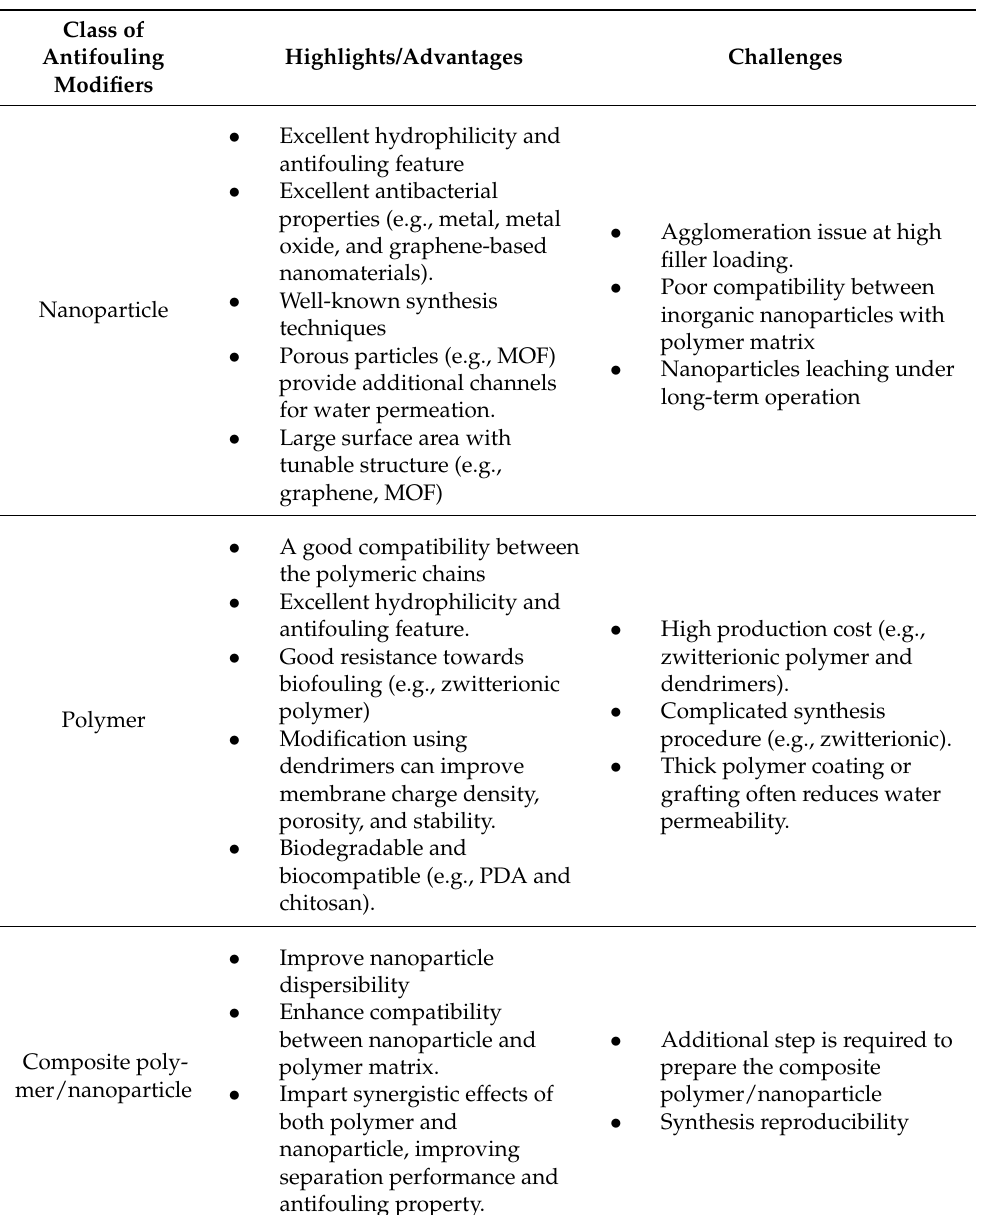
Table 4. Summary of highlights/advantages and challenges of different classes of antifouling modi-